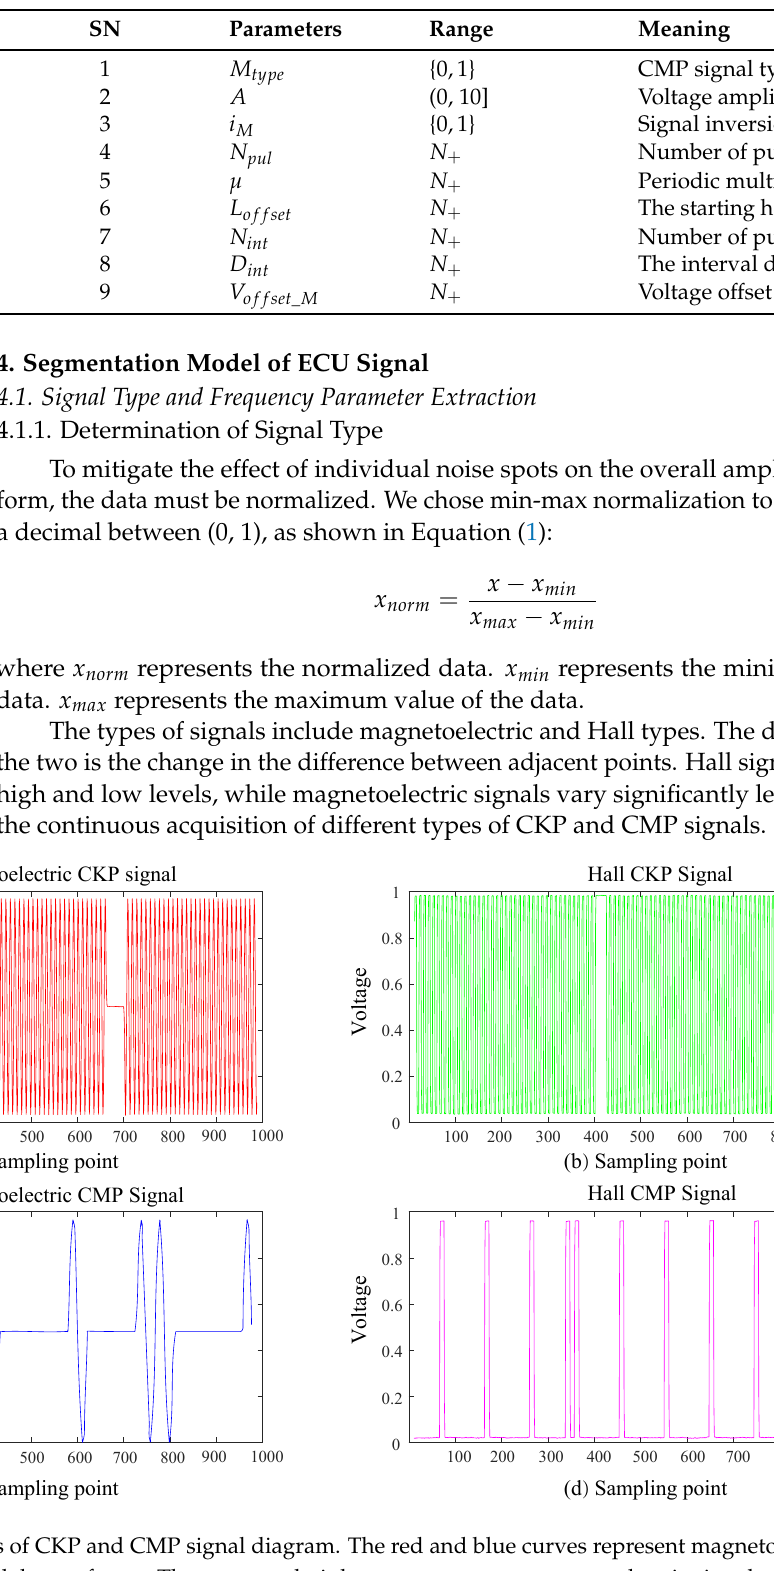
Table 2. CMP signal characteristic parameters.